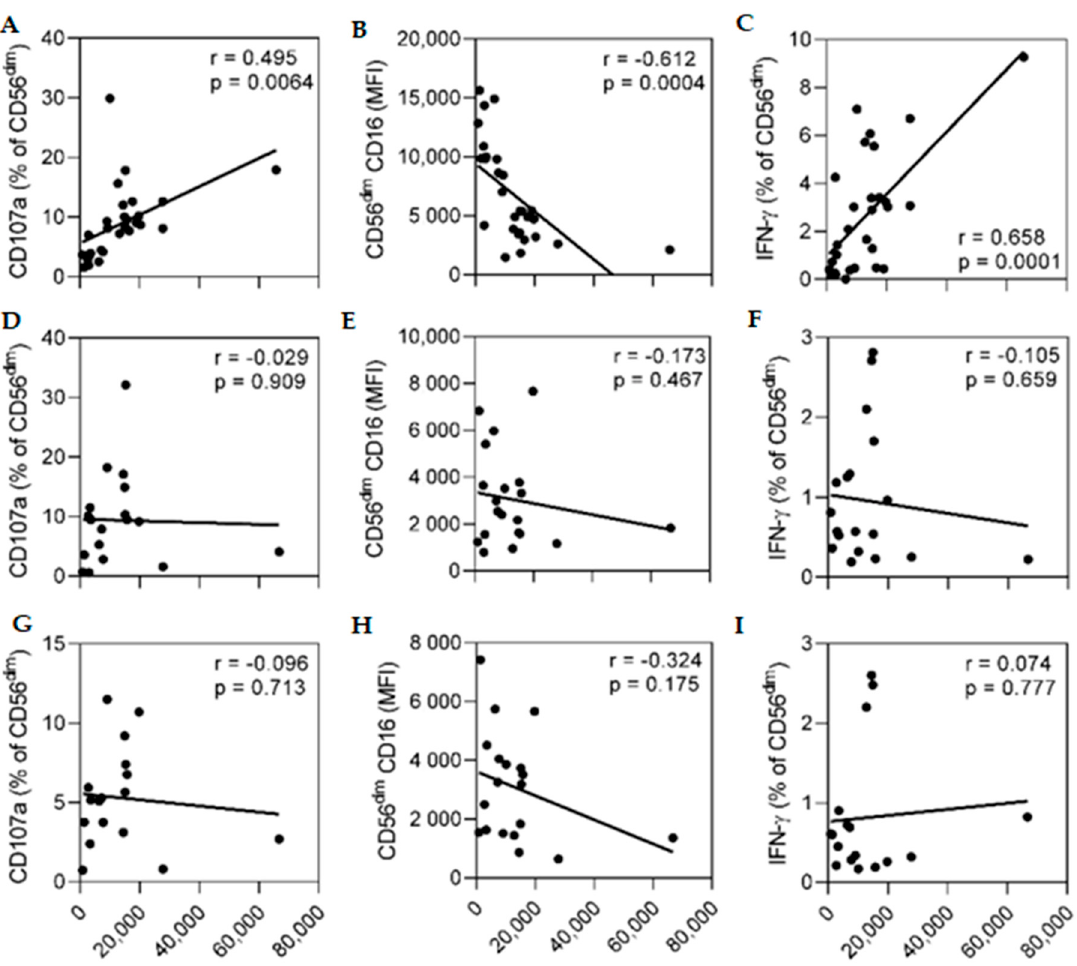
Figure 5. Correlation between vaccination-induced anti-GP antibody concentration and NK cell re- sponses. ADNKA responses in a single standardized donor readout ( A – C ) or from 19 individual study participants at Visit zero ( D – F ) or Visit two ( G – I ) were cultured with EBOV GP in the presence of serum collected from the trial individuals 21 days post-dose two (Visit two). For the standard readout, 27 sera were tested for each study time point. For the autologous readouts, 18 sera were tested for each study time point. NK cell CD107a ( A , D , G ), CD16 MFI ( B , E , H ) and IFN- γ ( C , F , I ) expression was compared against anti-GP antibody concentration (measured at Visit 2) (ELISA units/mL, Table 1). Goodness-of-fit line was determined by linear regression and r- and p -value analysis was performed by Pearson’s correlation. Significance was defined as p <